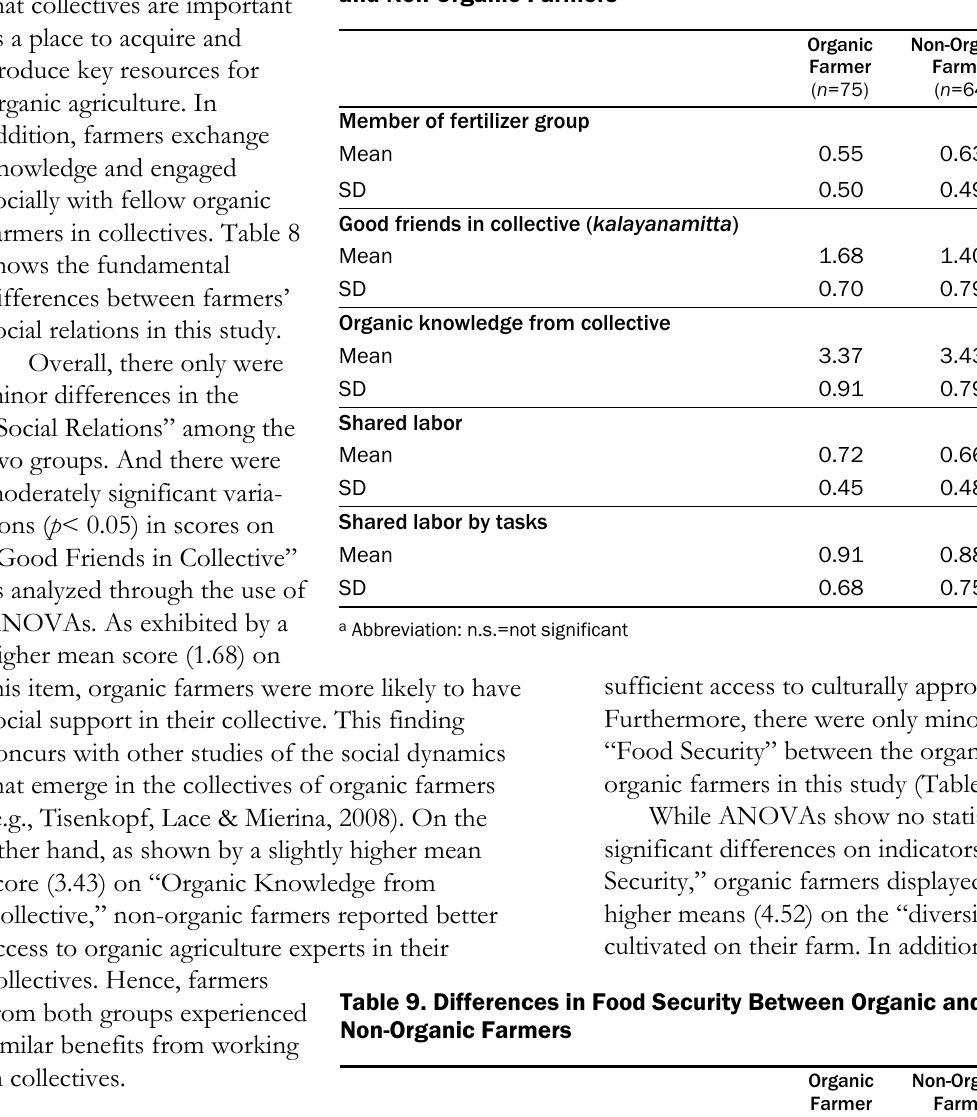
Table 8. Differences in Social Relations Views Between Organic and Non-Organic Farmers